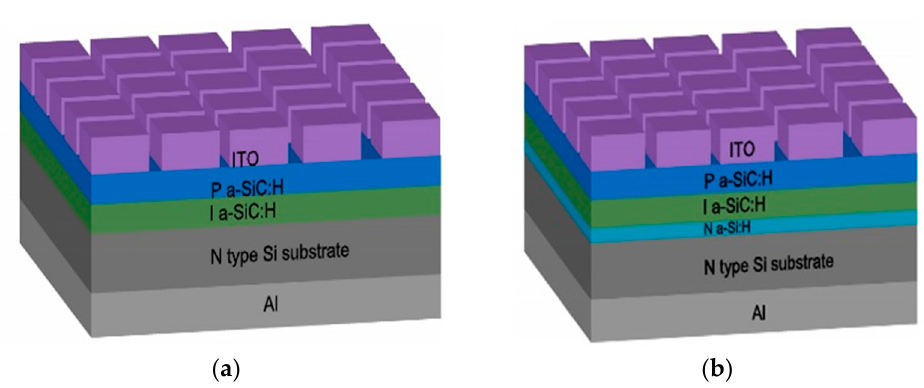
Figure 1. Schematic diagram of the LEDs fabricated: ( a ) PIN, and ( b ) PIN + N. Table 1. Deposition parameters of N + , P and I layers.